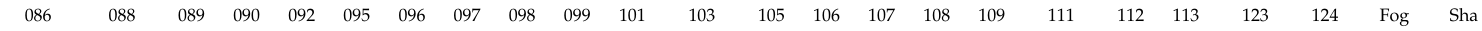
Table 4. Analysis of molecular variance (AMOVA)-based pairwise F ST between the 24 populations with 1023 permutations (below the diagonal) and mean F ST of each accession against all other accessions